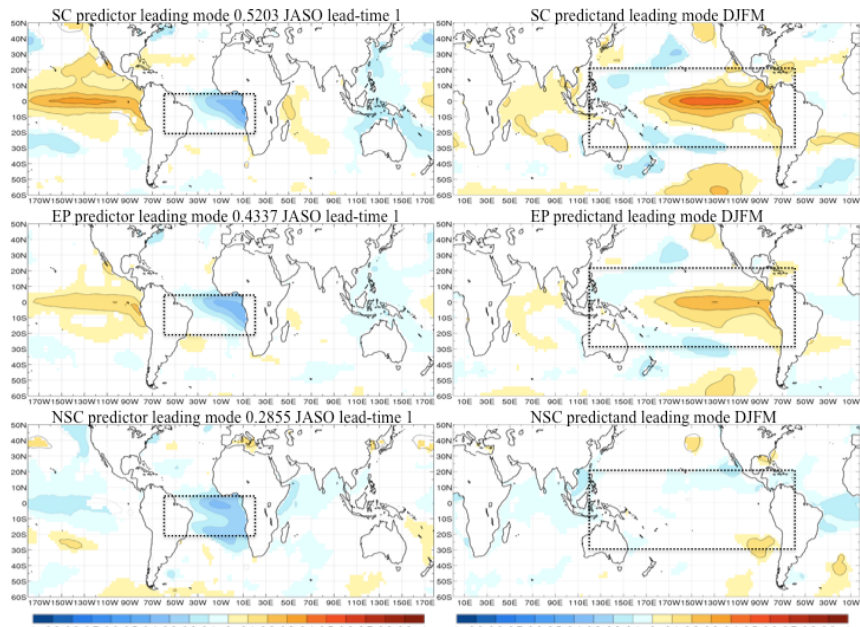
Figure 8. Regression maps obtained for the leading mode by applying MCA between SSTA in the tropical Atlantic (predictor) and SSTA in the tropical Pacific (predictand). Left column represents the homogeneous regression map done by projecting the expansion coefficient U onto global SSTA ( ◦ C) for predictor seasonal period. Right column represents the heterogeneous regression map done by projecting expansion coefficient U onto global SSTA ( ◦ C) for predictand seasonal period. Period SC (top panels), EP (middle panels) and NSC (bottom panels). Rectangles show the selected regions for predictor and predictand fields considered in the MCA analysis. Values are plotted in regions where statistical significance under a Monte Carlo test is higher than